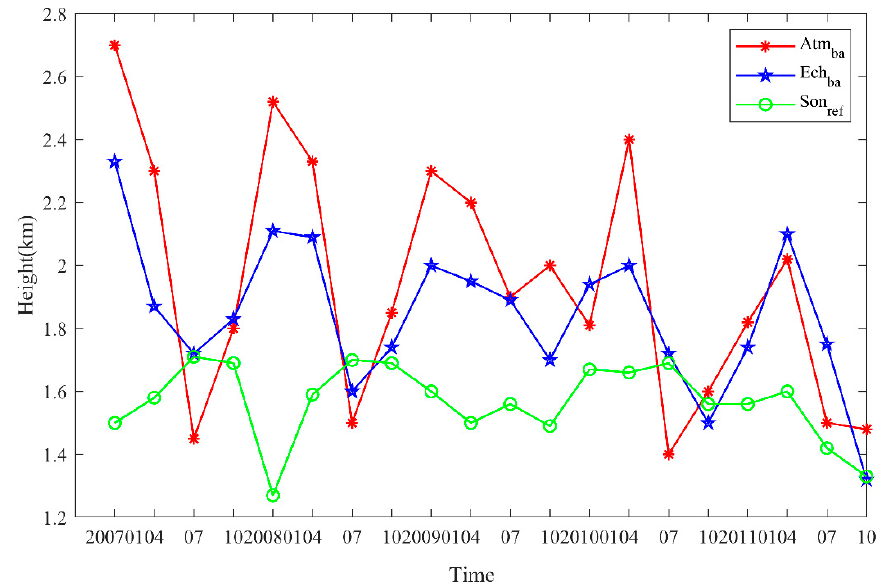
Figure 12. The interannual variability of MBLH in the waters near the South China Sea was derived from COSMIC’s atmprf and echprf bending angle and sonprf refractivity.